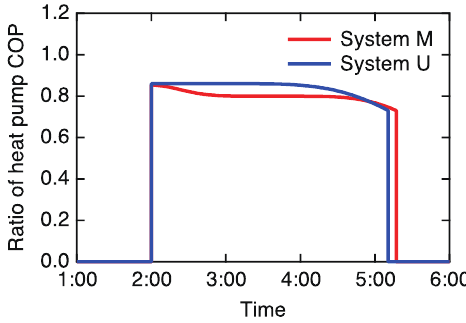
Figure 10. Comparison in hourly change in heat pump COP between systems M and U.